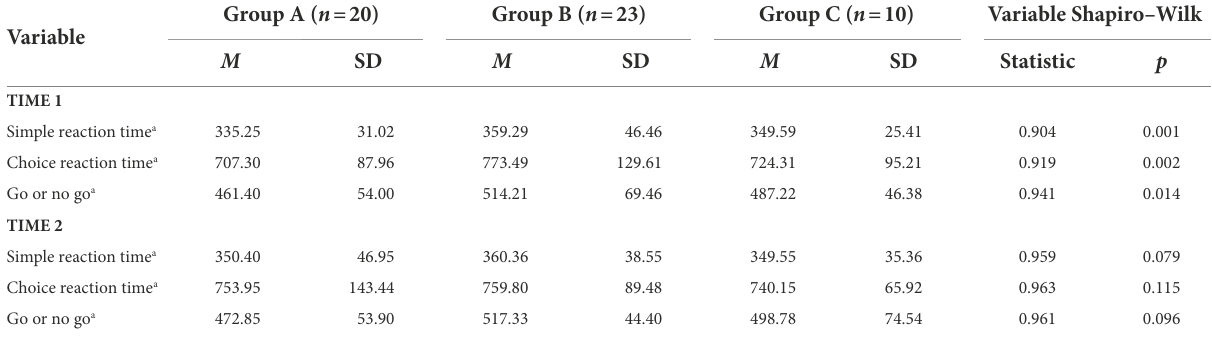
TABLE 2 Between-group comparison one-way analysis of variance.